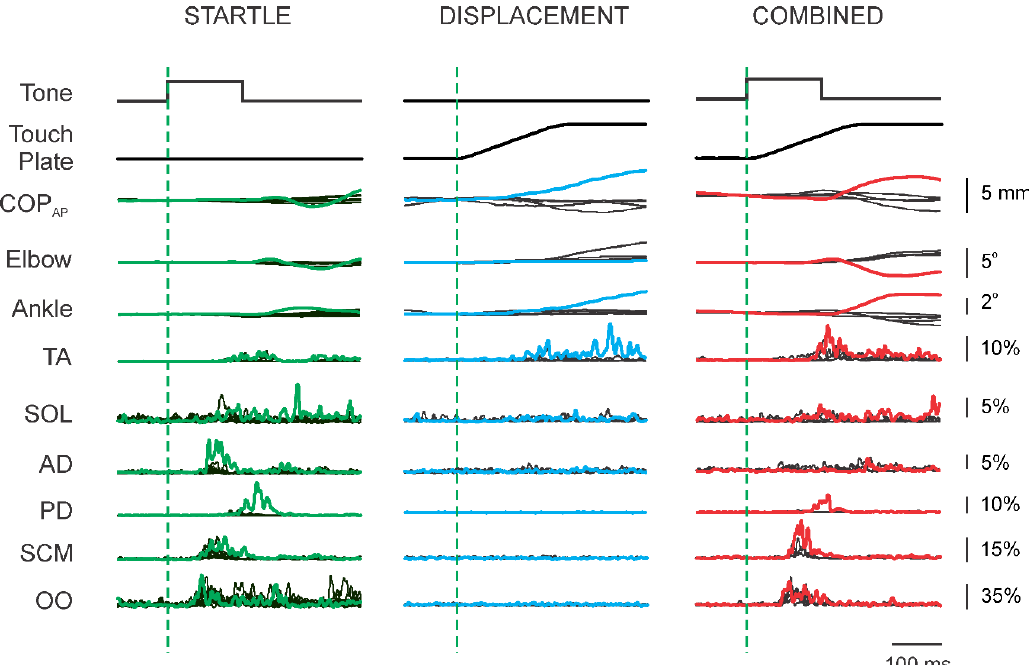
Figure 7. Sample data traces from a single participant who received the DISPLACEMENT stimuli after habituating to the STARTLE stimuli. Each cluster of traces represents the complete series of trials for that stimulus mode, with the coloured traces representing the first trial for that stimulus mode (Green, STARTLE; Blue, DISPLACEMENT; Red, COMBINED). The thin black lines of each cluster represent the subsequent trials. The vertical dashed line is aligned to the onset of the stimuli. Positive deflections in the COP AP traces represent forward, elbow traces represent extension, and ankle traces represent plantarflexion. COP AP , center of pressure anterior–posterior; TA, tibialis anterior; SOL, soleus; AD, anterior deltoid; PD, posterior deltoid; SCM, sternocleidomastoid; OO, orbicularis oculi.